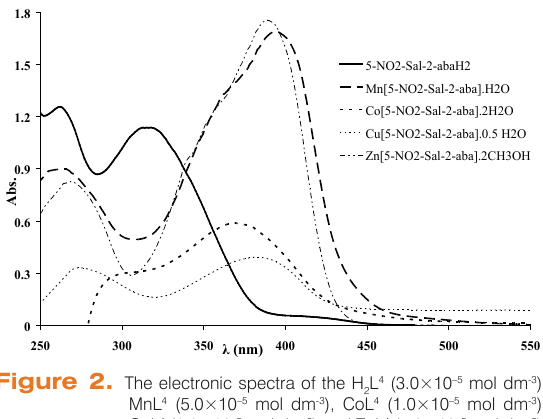
Figure 2. The electronic spectra of the H L 4 (3.0×10 –5 mol dm -3 ), 2 MnL 4 (5.0×10 –5 mol dm -3 ), CoL 4 (1.0×10 –5 mol dm -3 ),